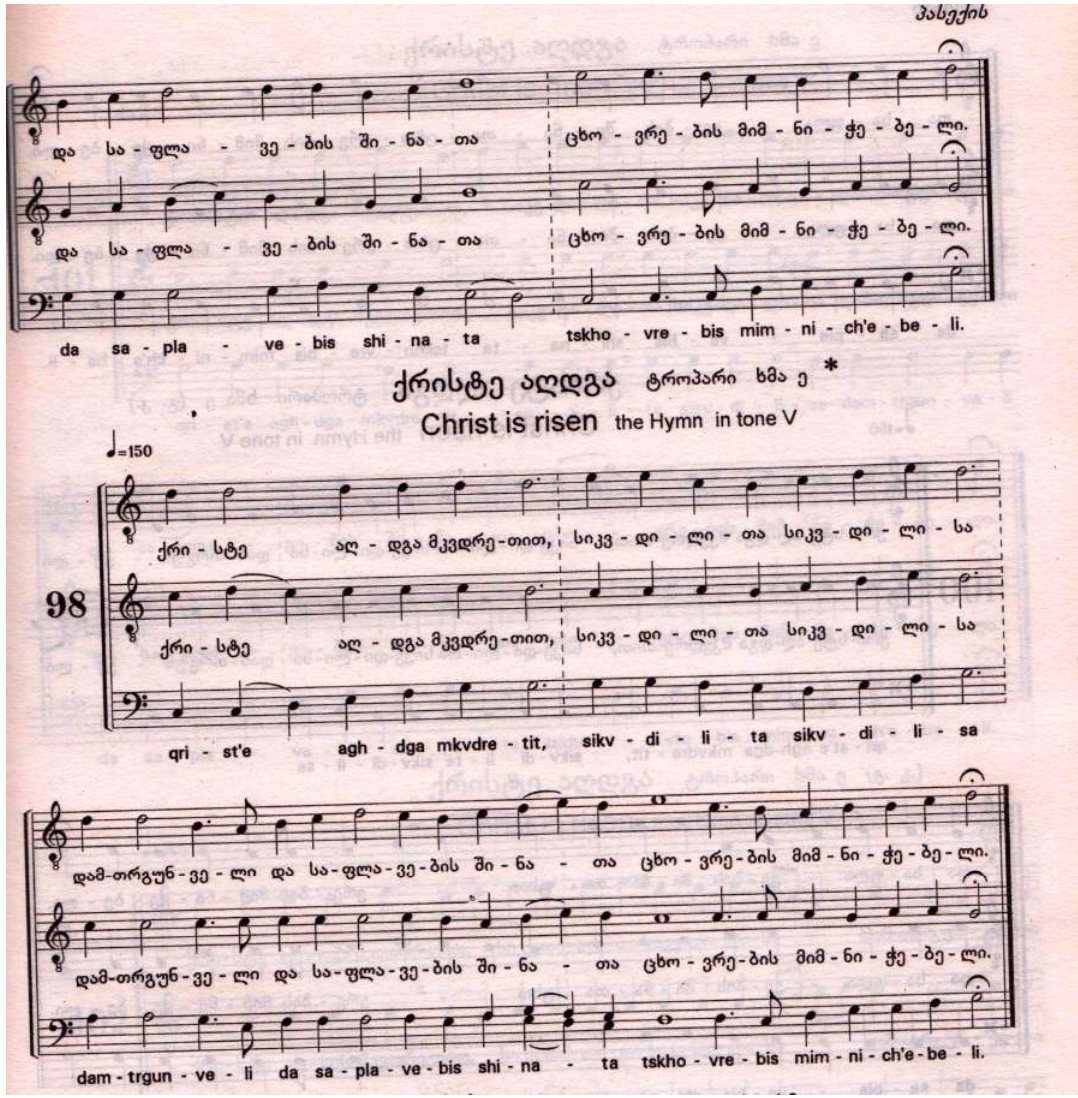
Figure 3. Paschal troparion; Gelati School.